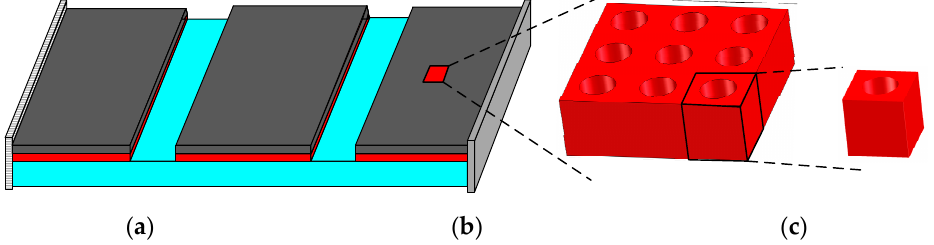
Figure 1. A multiscale system of structure with constrained layer damping treatment: ( a ) Macrostructure; ( b ) periodic material; ( c ) mesostructure.